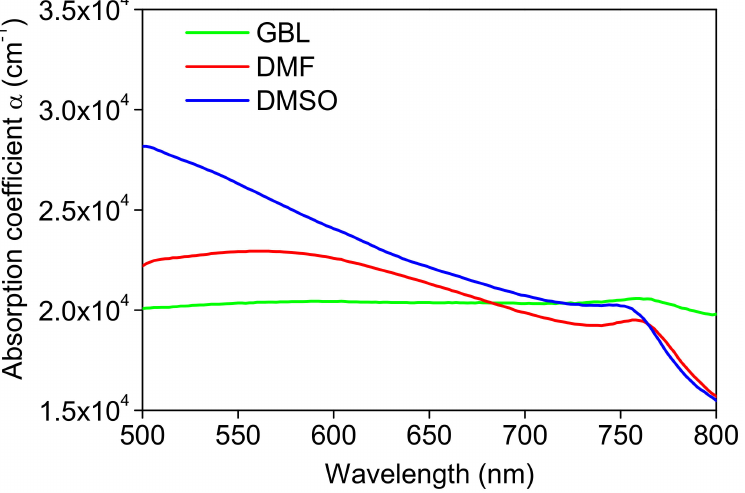
Figure 5. Absorption coefficient of the MAPbI 3 perovskite thin films prepared using different